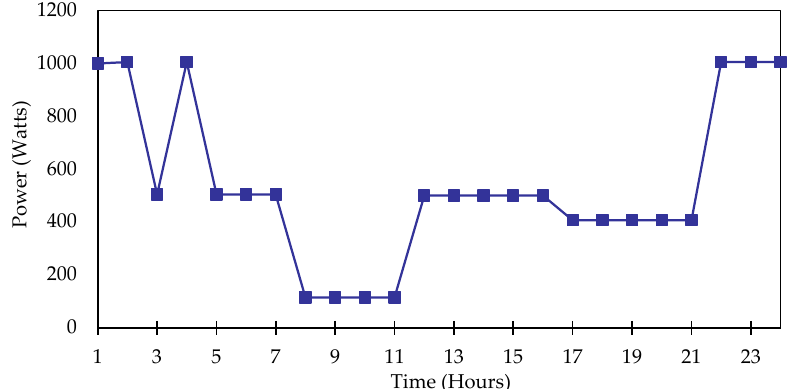
Figure 17. Demand curve of residential load.